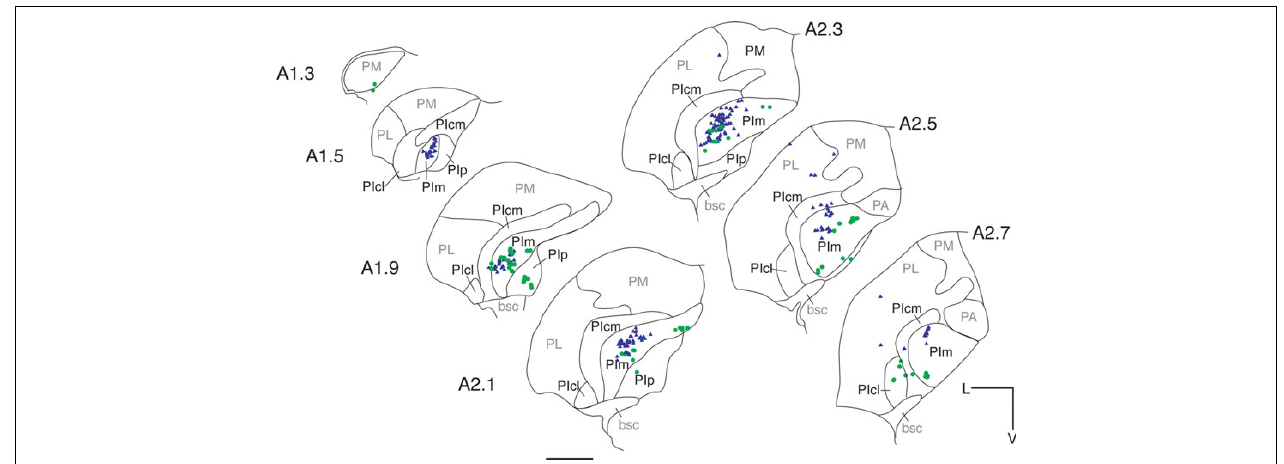
FIGURE 5 | Distribution of retinal afferent terminals and labeled area MT relay cells in the pulvinar nucleus of the left hemisphere. Digitized line drawings of the pulvinar nucleus and its subdivisions in coronal sections (Case NM55; 200 µm interval) demonstrating the distribution of area MT retrogradely labeled cell bodies (blue triangles) and contralateral retinal terminals (green dots) identifi ed as varicosities along labeled axons. Area MT relay cells are mainly clustered in the PIm away from its ventral border and